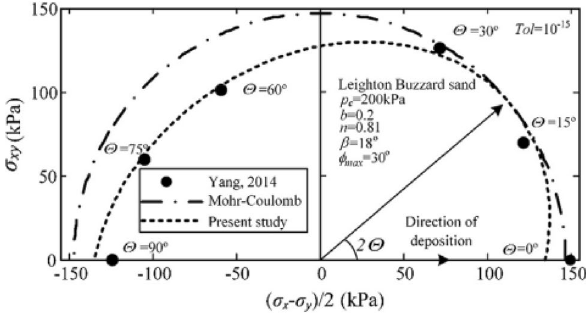
Figure 3. Validation of the newly proposed anisotropic yield criterion 14